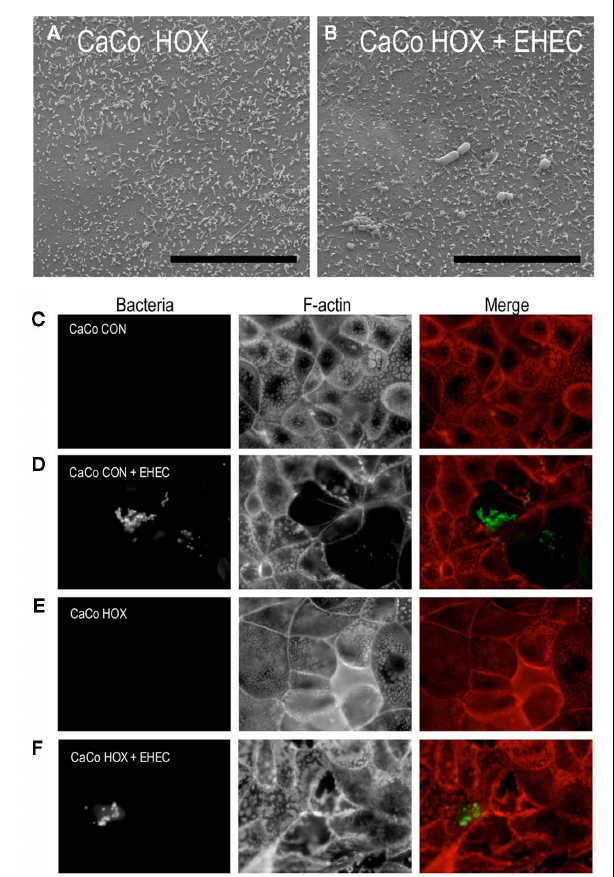
FIGURE 4 |The calpastatin overexpressing cell line, HOX, resisted microvillar effacement byAE pathogens. Uninfected polarized CaCo-2a HOX monolayers (A) and polarized HOX monolayers infected for 2h with EHEC (B) were visualized by SEM at 10,000 × magnification and with a 30˚ tilt. Scale bars for SEM’s are 10 μ m. Polarized control CaCo-2a CON (C,D) and calpastatin-overexpressing CaCo-2a HOX cells (E,F) were stained for F-actin (red) and EHEC (green) without (C,E) or with infection (D,F) by EHEC. F-actin was stained using Alexa 568-conjugated phalloidin; EHEC were stained with anti-O157